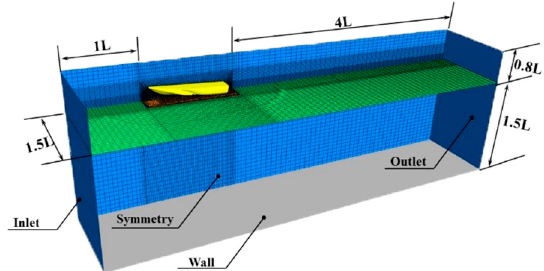
Figure 3. Calculation domain.